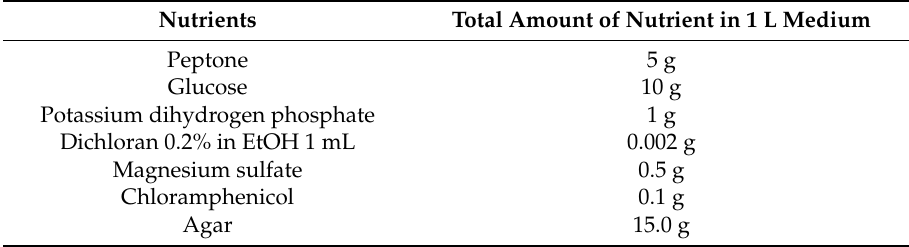
Table A9. Dichloran/Glycerol agar (DG18, Hocking and Pitt, 1980 pH: 5.6 ± 0.2 at 25 ◦ C).